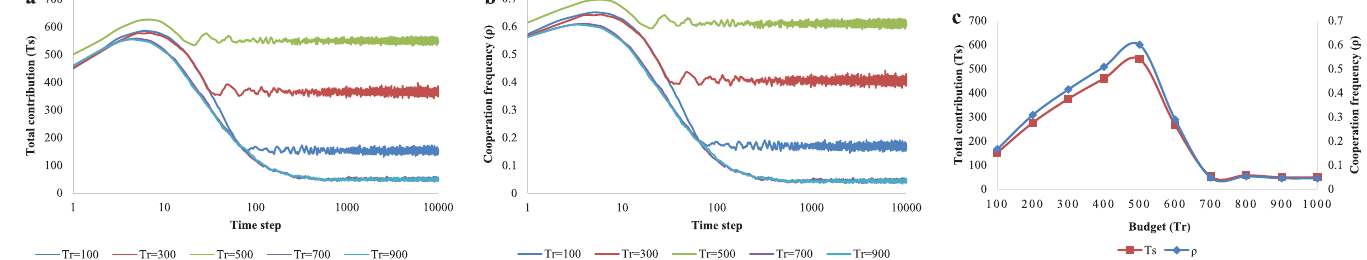
Fig 4. The evolution results of total contributions Ts and cooperation frequency ρ for different values of budget Tr . (a) The evolution process of total contributions for different budgets ( Tr = 100, 300, 500, 700, 900). (b) The evolution results of cooperation frequency for different budgets ( Tr = 100, 300, 500, 700, 900). (c) The equilibrium results of total contributions and cooperation frequency for different budgets from 100 to 1000 with an interval of 100.